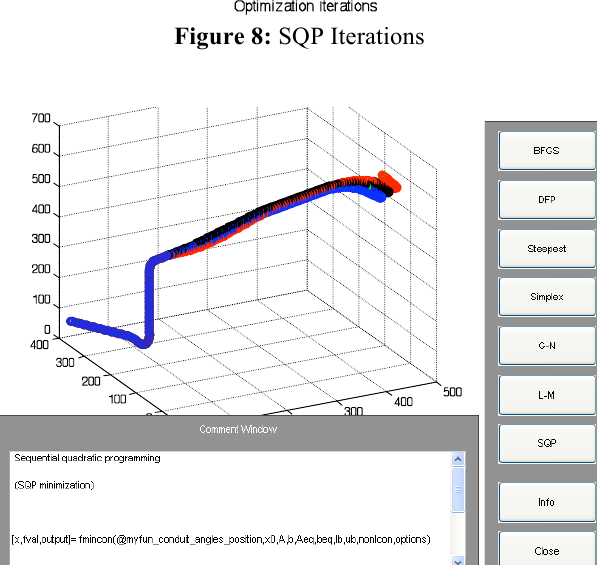
Figure 8: SQP Iterations